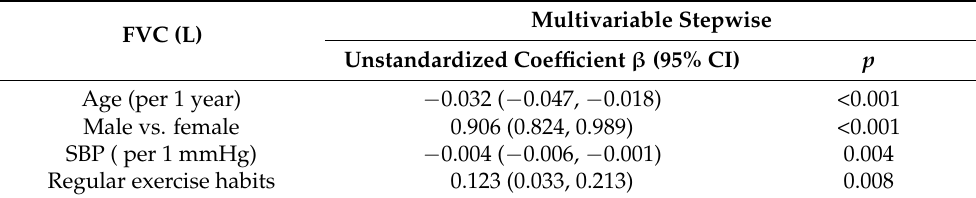
Table 4. Association of MMSE with FVC using multivariable stepwise linear regression analysis in participants with FEV1/FVC ≥ 70% ( n = 452).